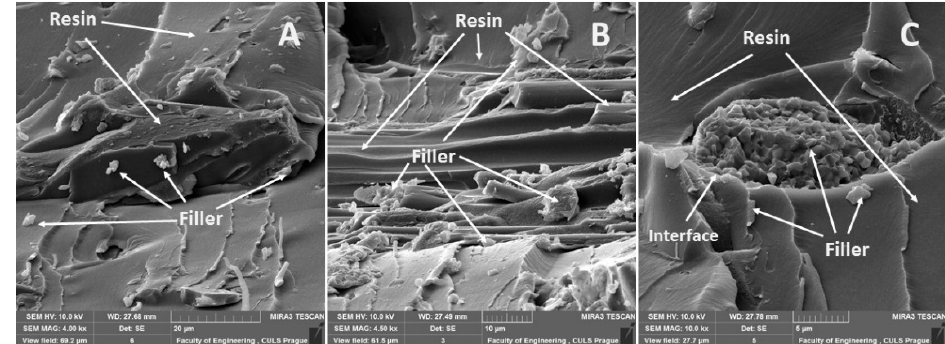
Figure 10. SEM micrographs—static tensile test of composite materials: ( A ) fracture surface of adhesive E53/TFF/100:22/C (mag 4.0k×), ( B ) fracture surface of adhesive E53/TFF/100:22/C (mag 4.5k×), ( C ) fracture surface of adhesive E53/TFF/100:22/C with detailed view of filler carbon powder (mag 10.0k×).